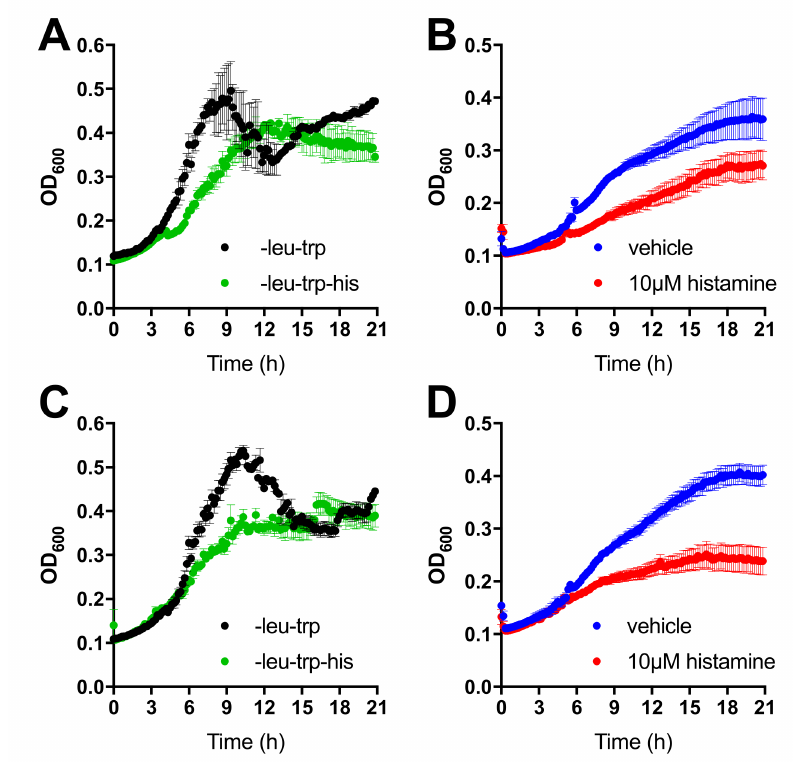
Figure 2. Interaction between H 4 R with TSPAN4 and CD63 as measured by MYTH liquid growth assay. ( A ) Co-expression of the H 4 R-Cub-LexA-VP16 and NubG-TSPAN4 constructs is evidenced by growth in media without leucine and tryptophane (black trace, selecting for diploids). Two-hybrid interaction and subsequent expression of the HIS3 reporter gene results in growth on media addi- tionally depleted for histidine (green trace, selecting for a two-hybrid interaction). ( B ) Modulation histidine-independent growth of the H 4 R-Cub-LexA-VP16 and NubG-TSPAN4 expression diploid by vehicle (blue trace) or 10 µ M histamine (red trace). ( C ) Interaction between H 4 R-Cub-LexA-VP16 and NubG-CD63 as describe in ( A ). ( D ) Modulation of the interaction between H 4 R (bait) and CD63 (prey) as described in ( B ). Data are displayed as mean ± SEM from 3 independent growth